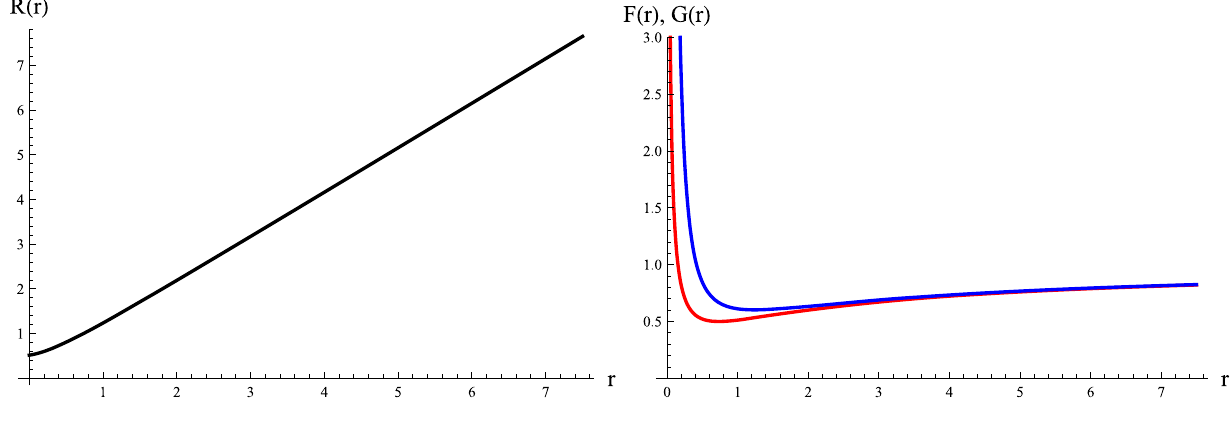
Fig. 3 Typical behaviors of R (left), F (right, red), and G (right, blue), where we have chosen a = 0, b = 2, and h = 1. At finite R , F and G diverge and terminate, while the surface is